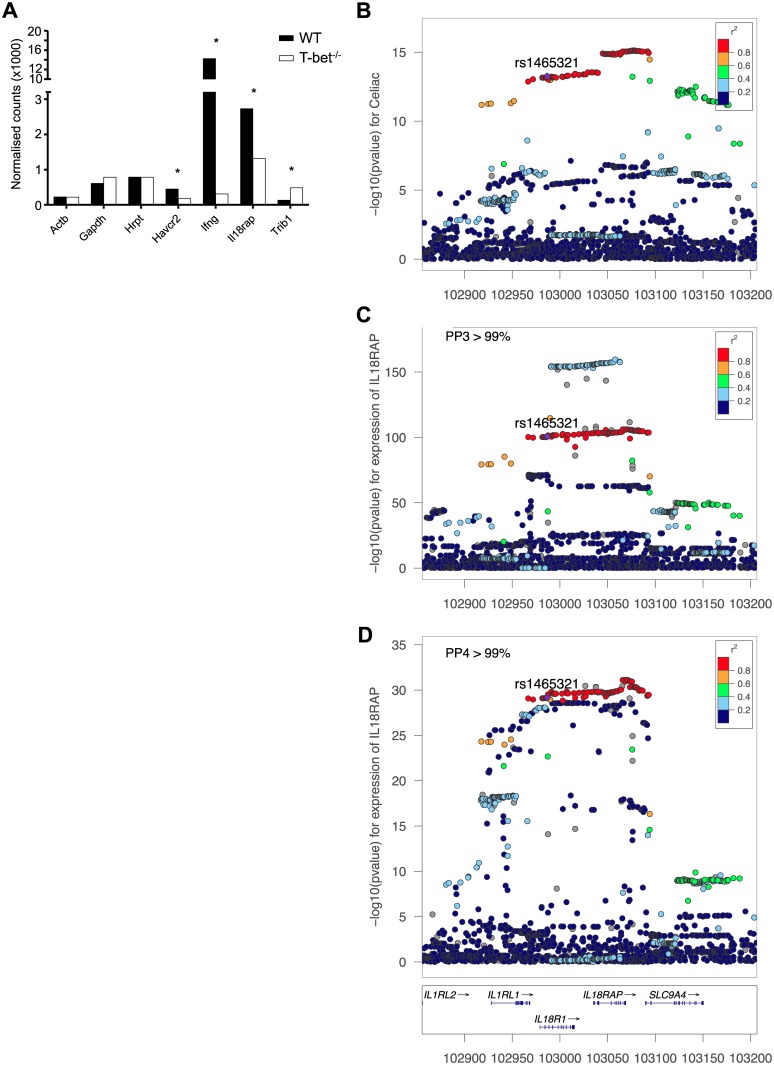
rs1465321 is an eQTL for IL18RAP and celiac disease.A. RNA abundance (size factor-normalised counts) for selected genes in wild type (WT) and T-bet deficient (T-bet KO) naive lymphocytes cultured under Th1 polarising conditions. * significant change in expression (p<0.05, Wald test after Benjamini-Hochberg correction). B. “Locus-zoom” plot showing the distribution of association p-values for celiac disease in the IL18RAP/IL18R1 chromosome region (genes shown below panel D). The x-axis shows the chromosome position. Colors show the level of linkage disequilibrium with rs1465321, which is indicated with a purple spot. C. “Locus-zoom” plot showing the distribution of association p-values for IL18RAP eQTL in 1,214 whole blood RNA samples. The Bayesian statistic for colocalisation with the celiac disease signal shows a posterior probability against colocalisation (PP3) greater than 99%, indicating that this primary whole blood IL18RAP eQTL signal is not compatible with a shared causal variant with celiac disease. D. “Locus-zoom” plot showing the secondary IL18RAP eQTL (conditional on rs1985329) signal in the same 1,214 whole blood RNA samples. For this secondary signal, the Bayesian statistic for colocalisation with the celiac disease signal shows a posterior probability in favour of colocalisation (PP4) greater than 99%, indicating that this secondary whole blood IL18RAP eQTL signal is compatible with a shared causal variant with celiac disease.